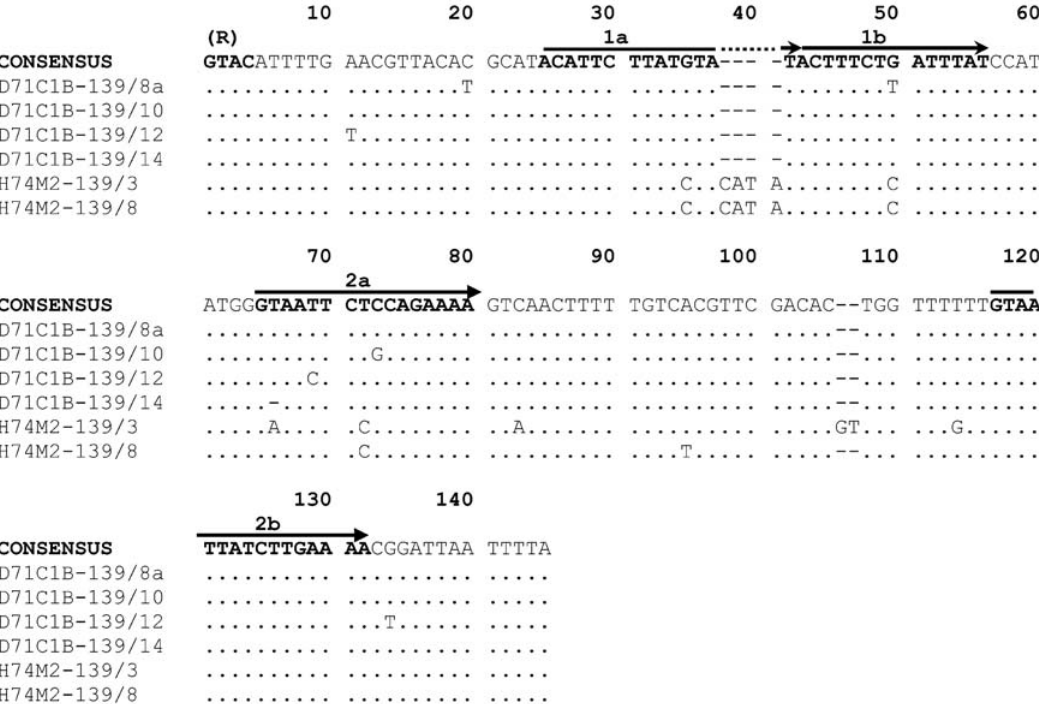
Figure 1 - Alignment containing the sequences of the SSS139 satellite DNA from Drosophila gouveai (H74M2) and Drosophila seriema (D71C1B) aligned with the SSS139 consensus sequence. The direct subrepetitions 1a and 1b (78.6% similarity) and 2a and 2b (81.25% similarity) are in bold and in- dicated with arrows. (R) Indicates the location of the Rsa I restriction site (GTAC). (.) Indicates similar bases, (-) indicates indels .